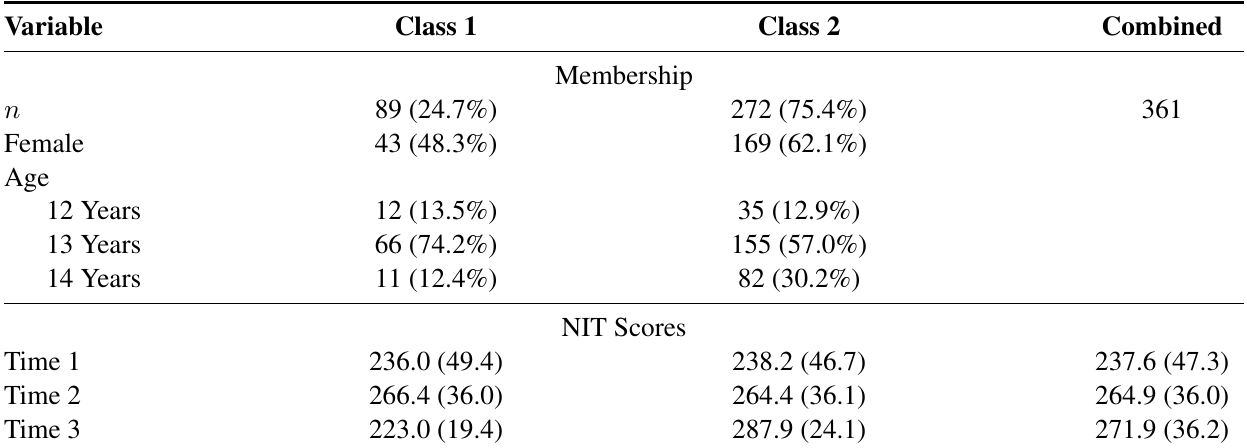
Table 6. Descriptive statistics for latent